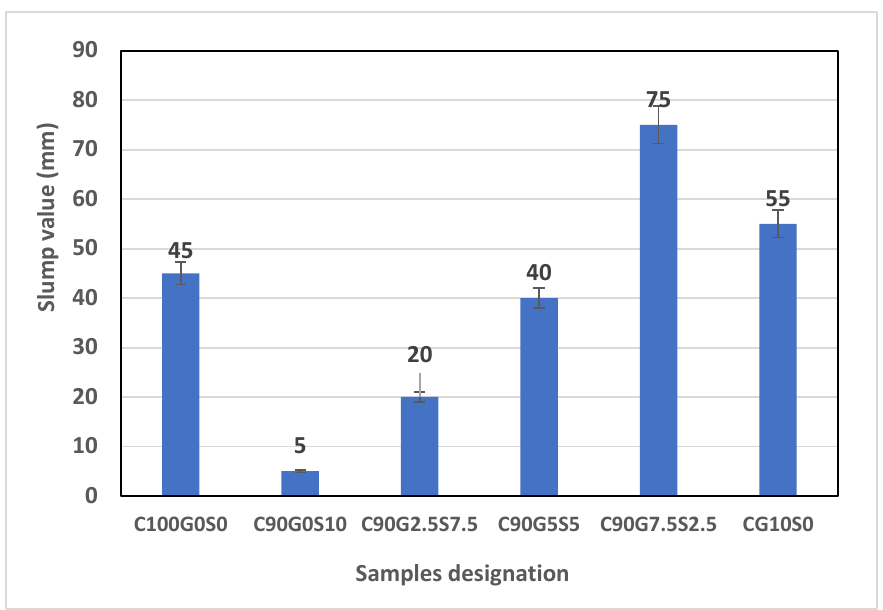
Figure 4. Effect of silica fume/waste glass powder synergy on concrete workability.